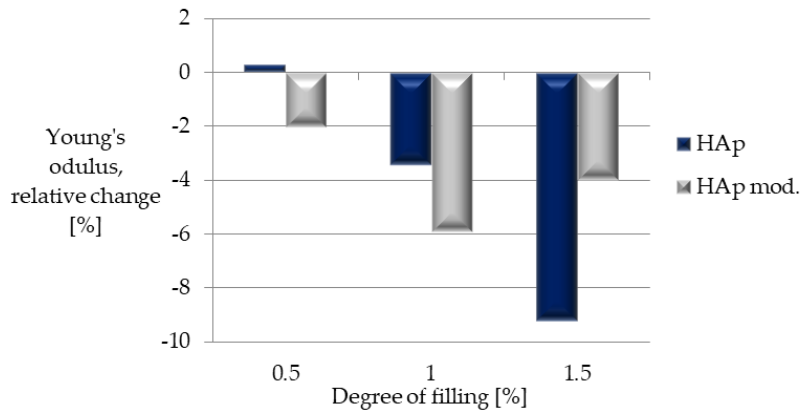
Figure 20. Relative change in Young ’ s modulus with respect to unfilled PLA.